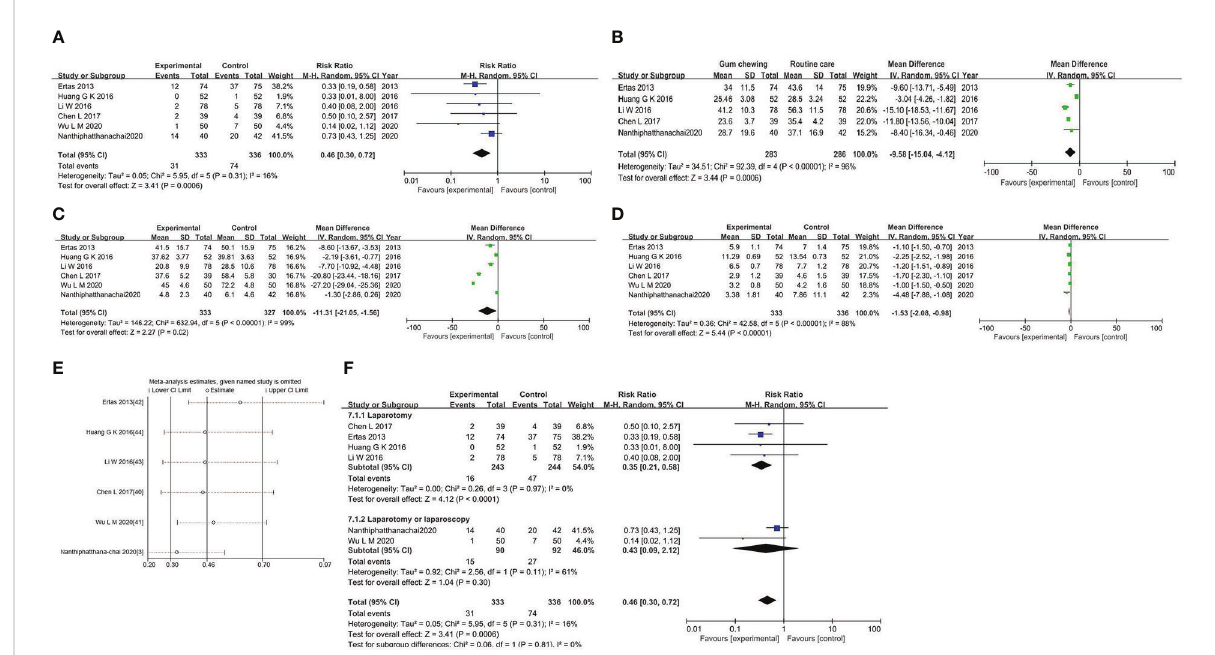
FIGURE 3 (A) Forest plot for the incidence of postoperative ileus. (B) Forest plot for the time to fi rst fl atus. (C) Forest plot for the time to fi rst bowel movement. (D) Forest plot for the length of hospitalization. (E) Sensitivity analysis in studies assessing the impact of gum chewing. (F) Forest plot for the subgroup analysis.